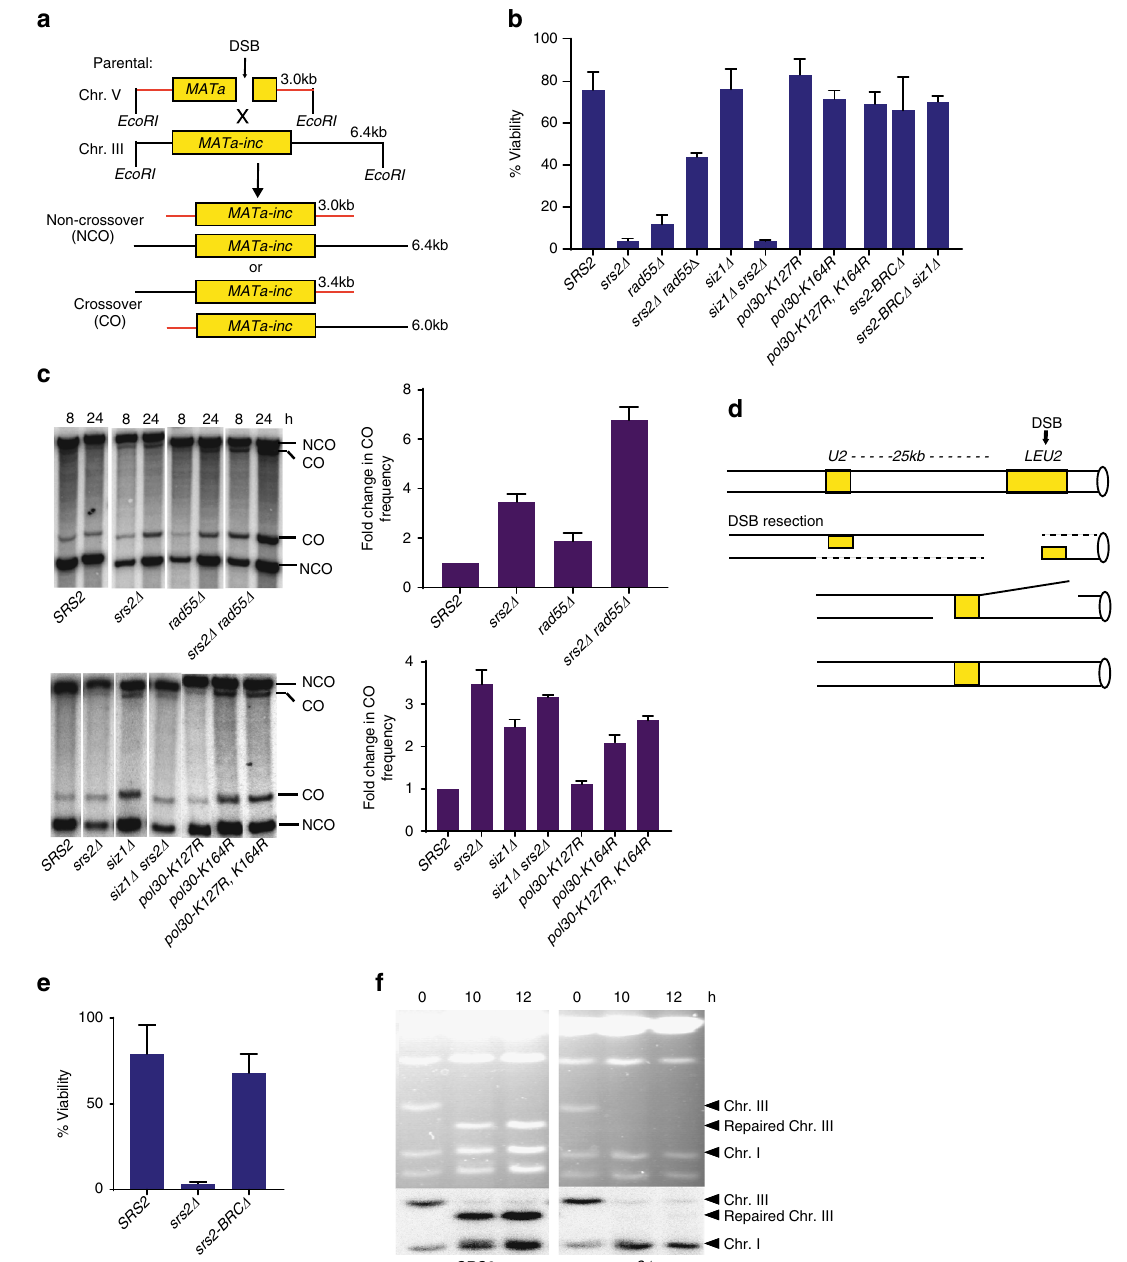
Fig. 5 Anti-toxic function of Srs2 during various DSB repair pathways. a Ectopic gene conversion is initiated by DSB introduced by HO endonuclease at MAT a inserted at the ARG5,6 locus on Chr. V and proceeds by using homologous MAT a-inc sequence on Chr. III as a template. The schematic explains the assay to distinguish crossover from non-crossover products of GC. b Cell viability re fl ecting the ef fi ciency of GC in various mutant backgrounds. c Crossover (CO) and non-crossover (NCO) GC products detected by Southern blot analysis (left, top panel) at 8 h and 24 h for SRS2 , srs2 Δ , rad55 Δ , and rad55 Δ srs2 Δ . CO and NCO GC products were also detected at 8 h for various other mutants (left, bottom panel). d The schematic of DSB repair system in YMV80 strains where DSB is induced at LEU2 by HO endonuclease on Chr.III and repaired by SSA/BIR using U2 as a template. e Cell viability in SRS2 and srs2 mutants following SSA/BIR. f CHEF gels showing analysis of repair by SSA/BIR in SRS2 (wild type; left) and srs2 Δ (right). Upper panel: Ethidium Bromide stained gel. Lower panel: Southern blot analysis using ADE1 -speci fi c probe highlighting Chrs. I and III. Quanti fi cation of cell viability and fold- change in CO frequency was based on ≥ 3 independent experiments and are presented as means with standard deviations